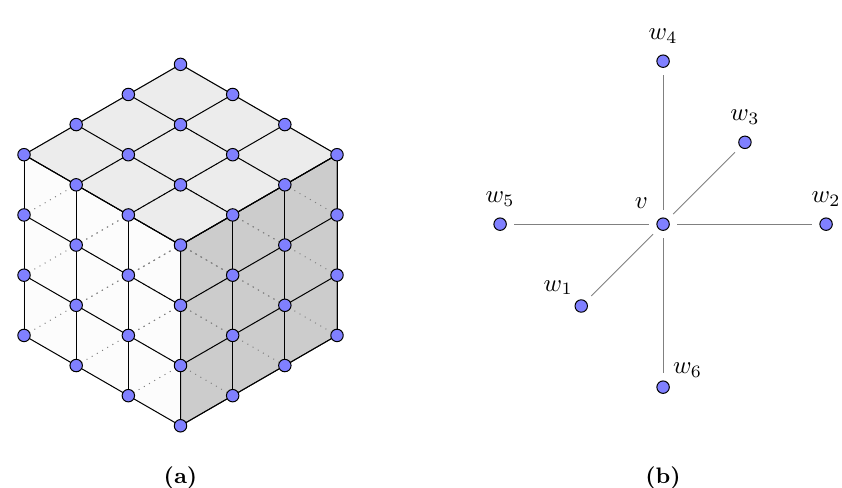
Figure 9 . (a) A square lattice in d = 3 : Here each blue dot represents a local Hilbert space C k : (b) A visual representation of the reduced ground state on a single vertex v and its neighbors f w g 1 ; : : : w 6